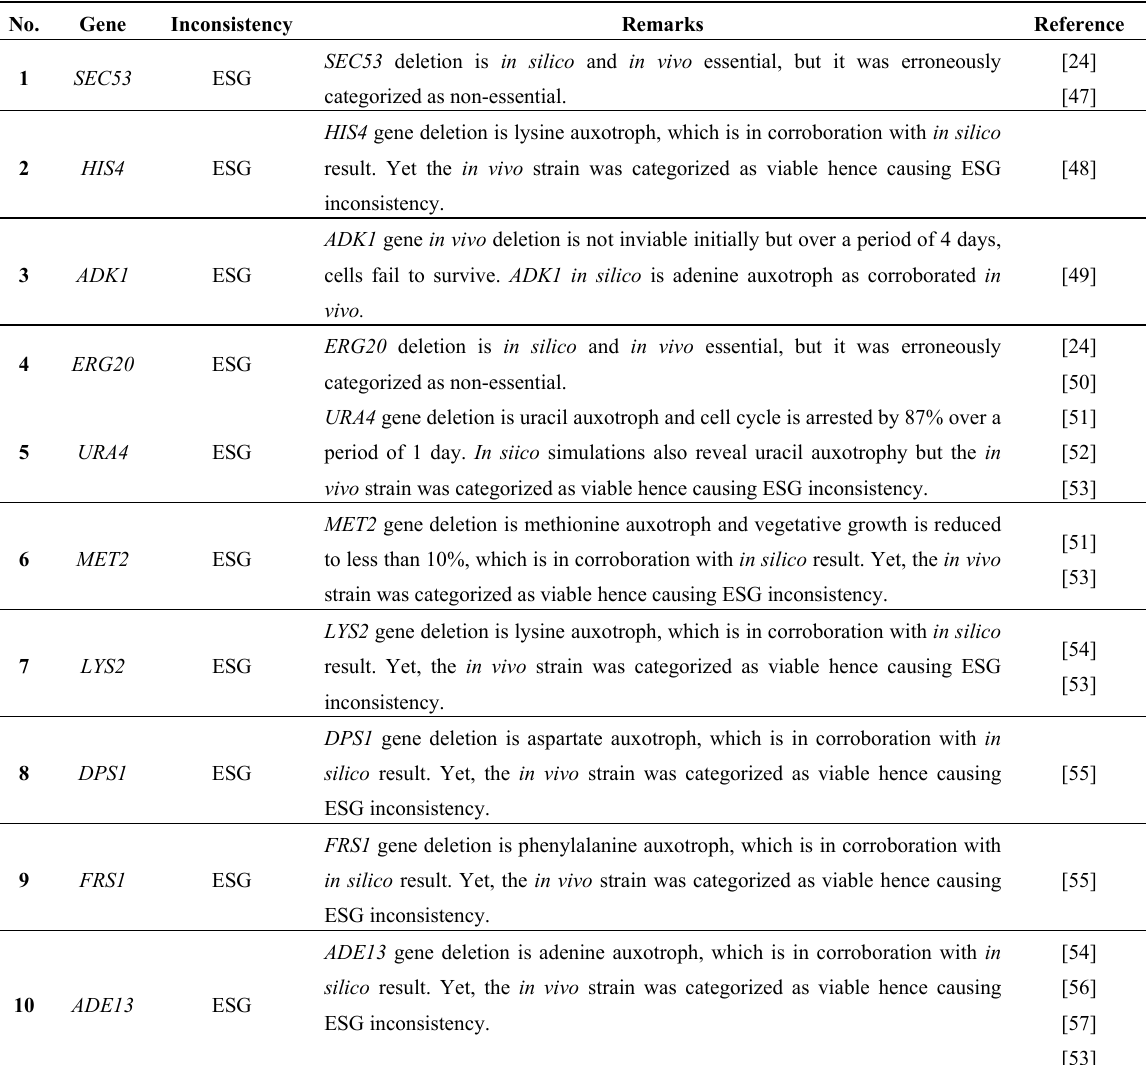
Table 3. Clarifications on 14 in silico in vivo